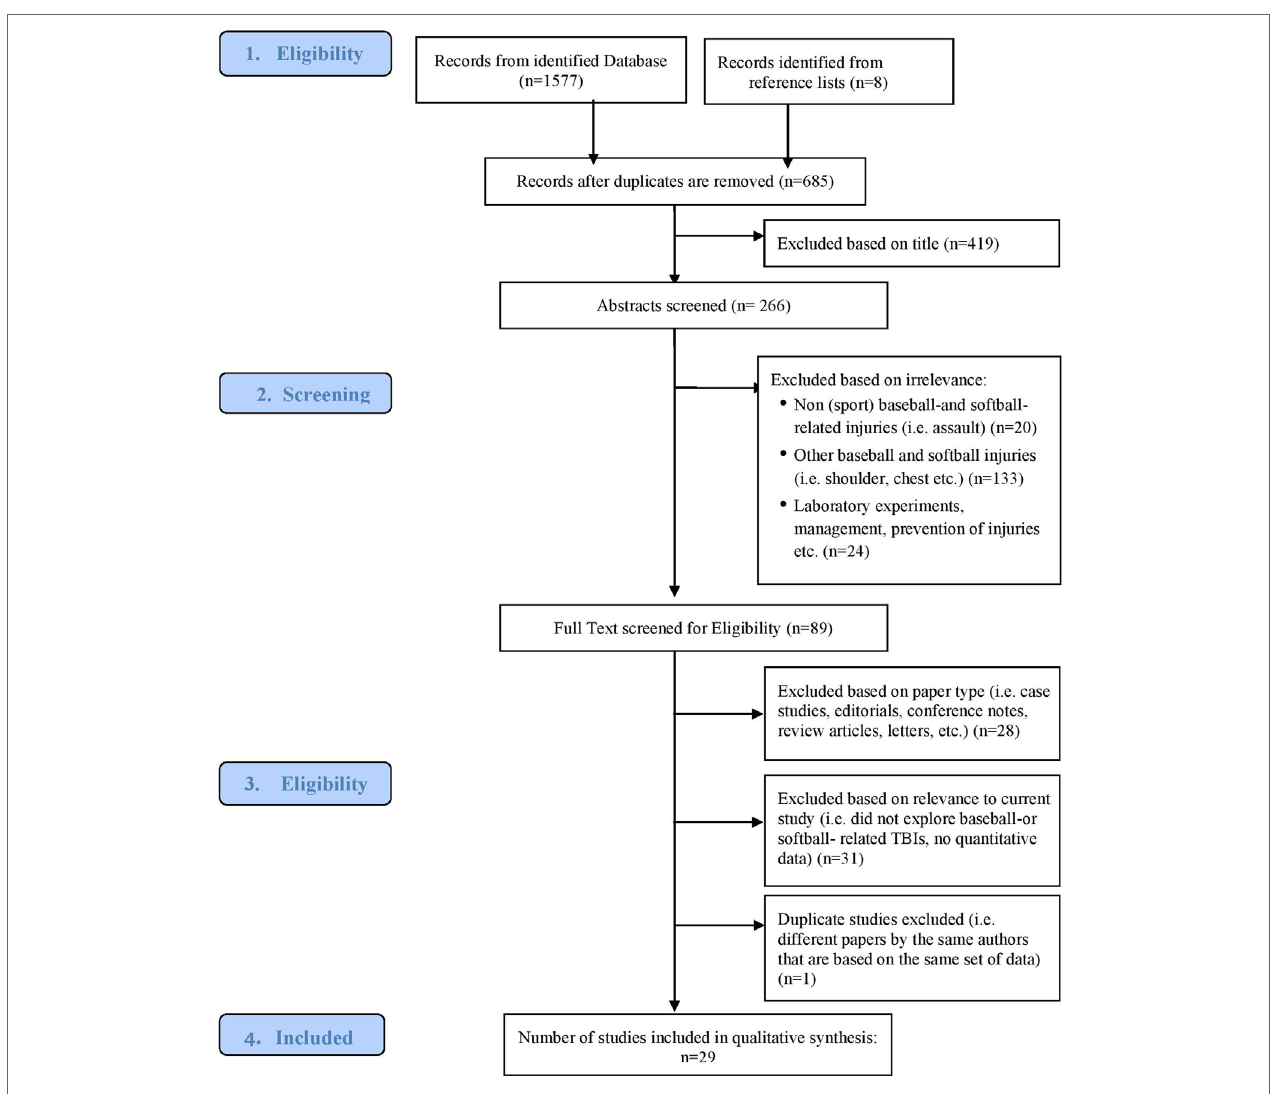
FiGURe 1 | Consort